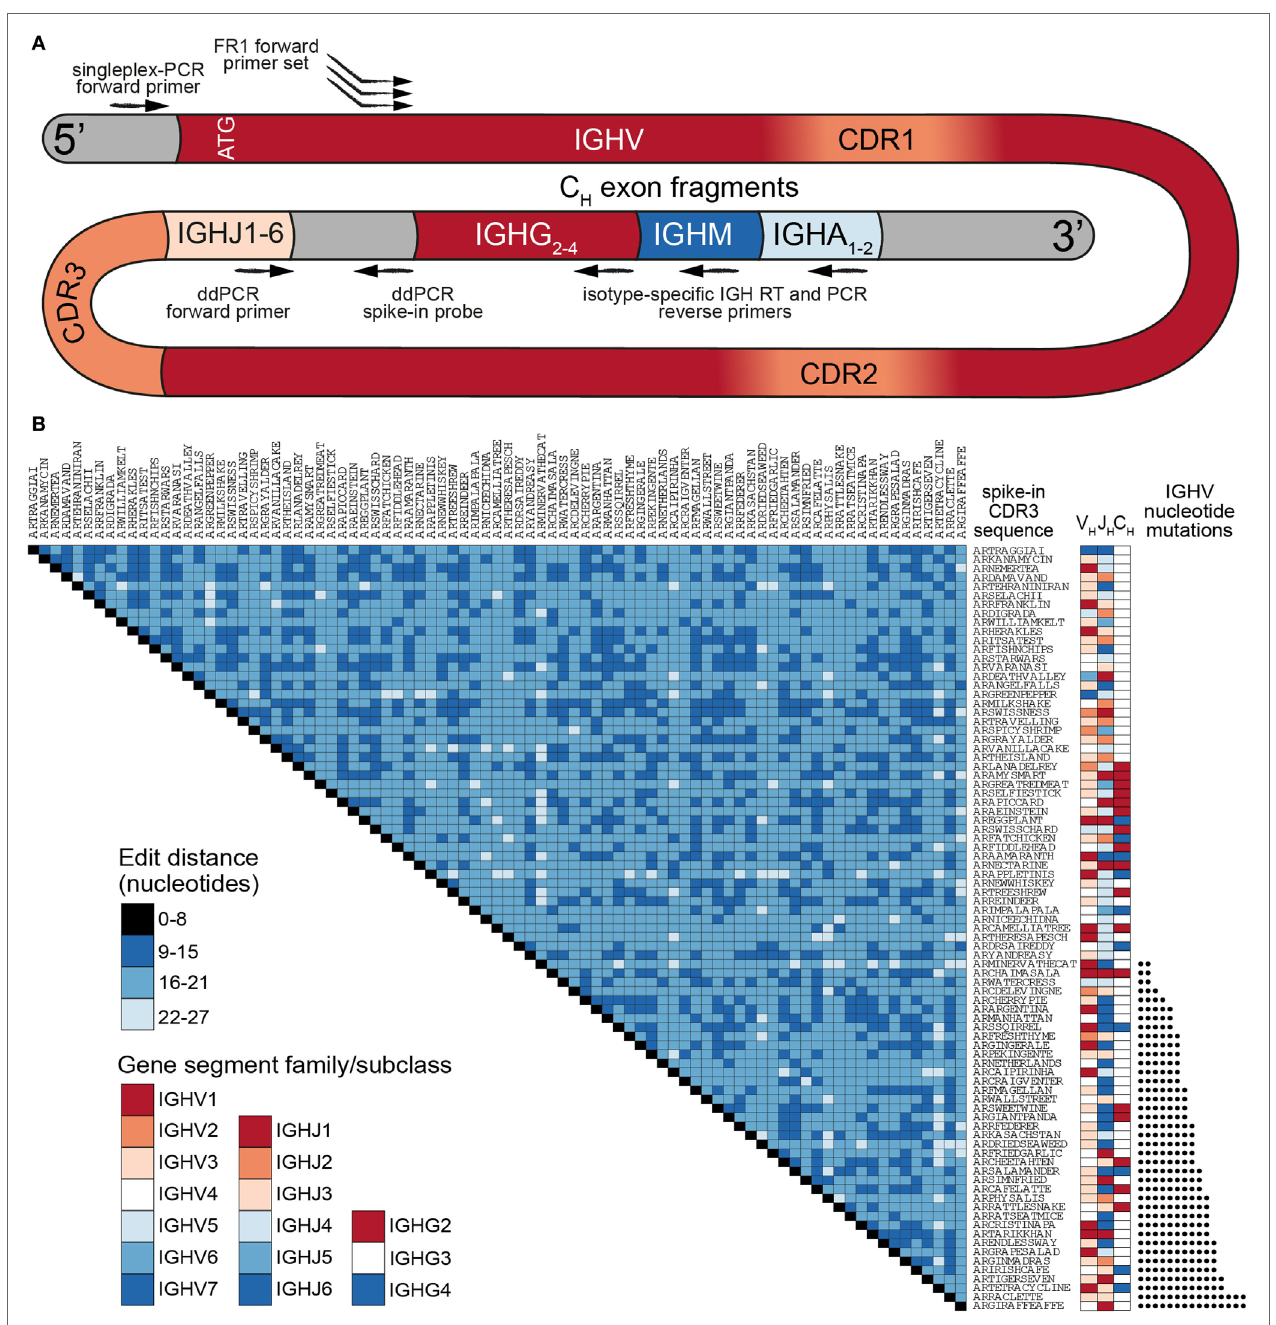
FIgURe 1 | A comprehensive set of human synthetic spike-in standards for Ig-seq. (A) Schematic showing the prototypical spike-in with the following regions (5 ′ –3 ′ ): a conserved non-coding region, ATG start codon, IGHV region with framework region 1 (FR1) specific for multiplex-PCR, IGHJ regions, non-coding synthetic sequence identifier [specific for digital droplet PCR (ddPCR) probes], and downstream heavy-chain constant domain sequences (IGHG, IGHM, IGHA) containing primer-binding sites used for cDNA synthesis. Each spike-in contains a complete VDJ open reading frame, including nucleotides upstream of the ATG start codon, and downstream constant domain sequences containing primer-binding sites used for sample cDNA synthesis. (B) Pairwise comparisons based on a.a. Levenshtein edit distance of all 85 standard complementarity determining region 3 (CDR3) sequences. The germline IGHV and IGHJ segment family usage and IgG subclasses are denoted. 39 spike-ins contain rationally designed nt somatic hypermutation (SHM) (black circles) across the IGHV